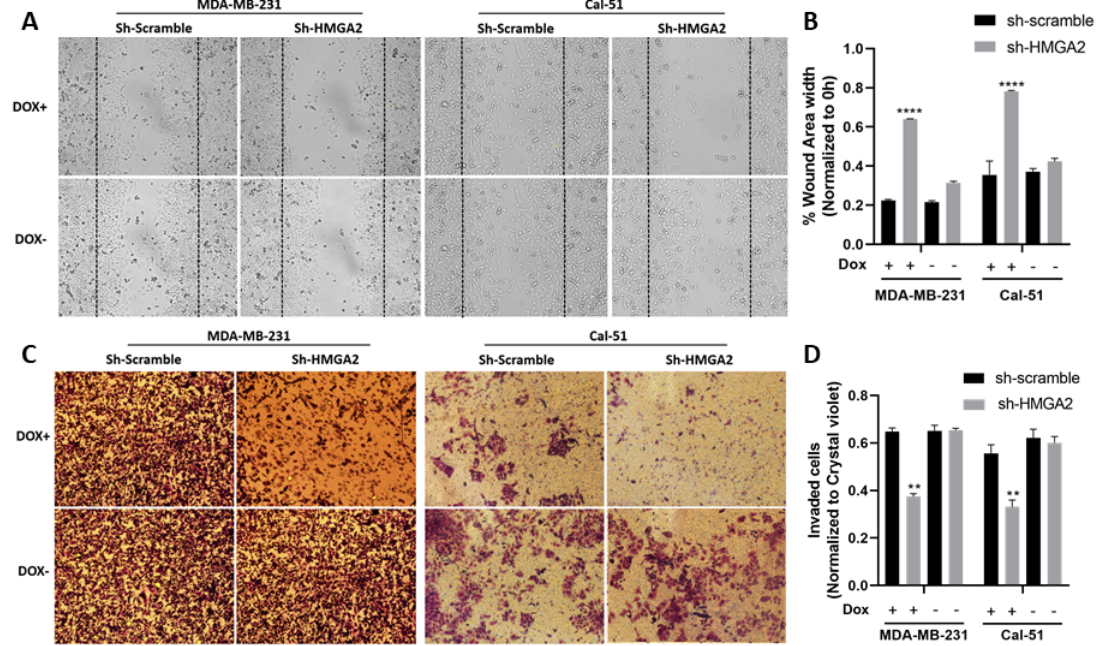
Figure 4. HMGA2 silencing decreases the invasion and migration of TNBC cells . Micrograph showing reduced invasion of HMGA2-silenced TNBC cells compared to corresponding TNBC control cells ( A ). The number of HMGA2-silenced migrated cells were quantified and compared to shScramble cells for both MDA-MB-231 and Cal-51 cell lines after 48h treatment with or without doxycycline (Dox) ( B ). Micrograph showing that HMGA2 -silenced TNBC cells exhibit reduced invasion (decreased cell migration into the wound gap area) compared to corresponding TNBC control cells ( C ). The wound area width was quantified and compared to that of shScramble cells for both cell lines ( D ). The results are shown as mean±SD ( n = 3) versus shScramble cells, ** p < 0.01, **** p < 0.0001 by t -test.